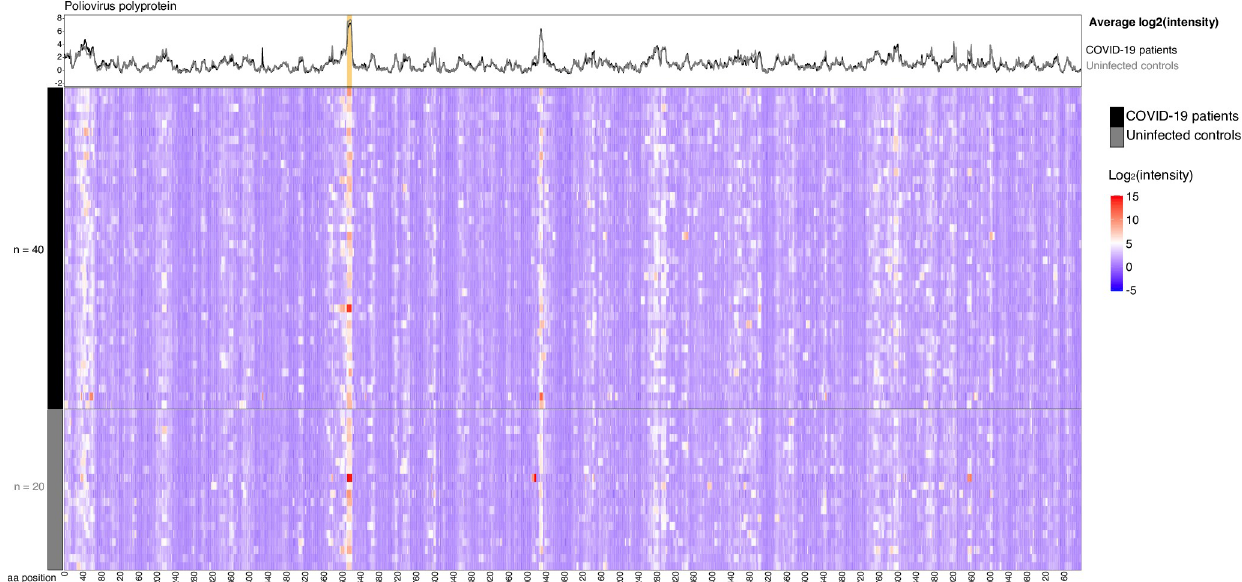
Fig 1. Patients and controls show reactivity to a poliovirus control. Sera from 20 controls collected before 2019 were assayed for IgG binding to the full proteome of human poliovirus 1 on a peptide microarray. Binding was measured as reactivity that was > 3.00 standard deviations above the mean for the log 2 -quantile normalized array data. Patients and controls alike showed reactivity to a well-documented linear poliovirus epitope (start position 613 [IEDB. org]; orange shading in line plot). The data used in this analysis can be accessed online at: https://github.com/Ong-Research/UW_Adult_Covid-19. COVID AU : AbbreviationlistshavebeencompiledforthoseusedinFigs 1 (cid:0) 7 : Pleaseverifythatallentriesarecorrect : -19, coronavirus disease 2019; IgG, immunoglobulin G.